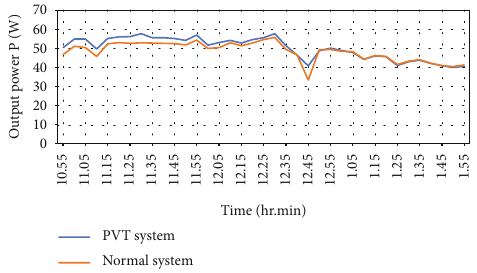
Figure 8: Output power of PVT and normal system. Average improvement in output power of PVT system is 2.5W, and maximum improvement is 7.4